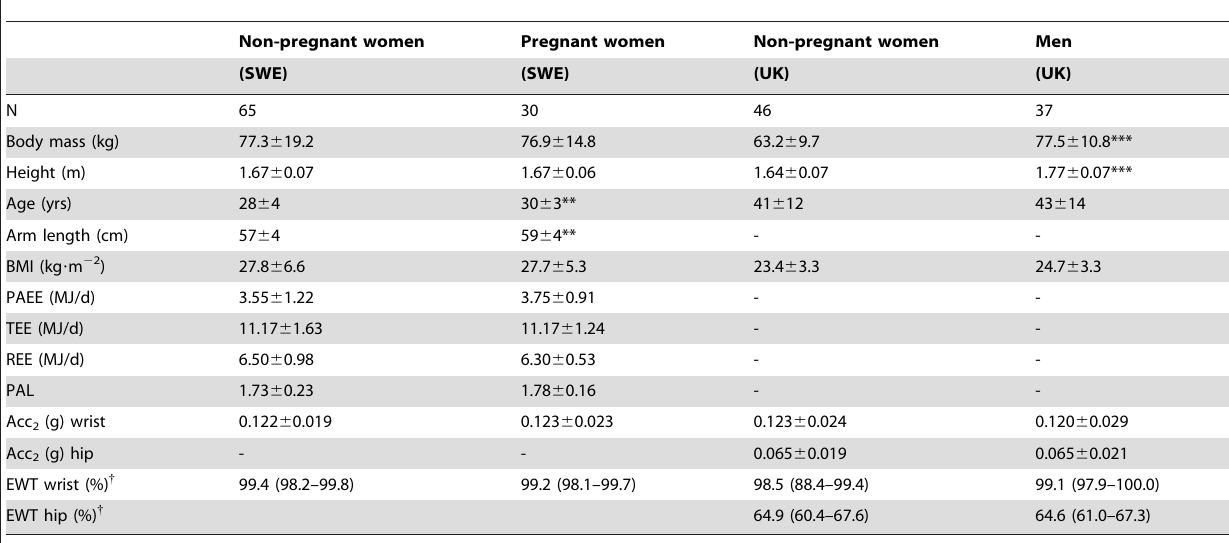
Table 1. Participant characteristics providing at least one valid day of accelerometer data.